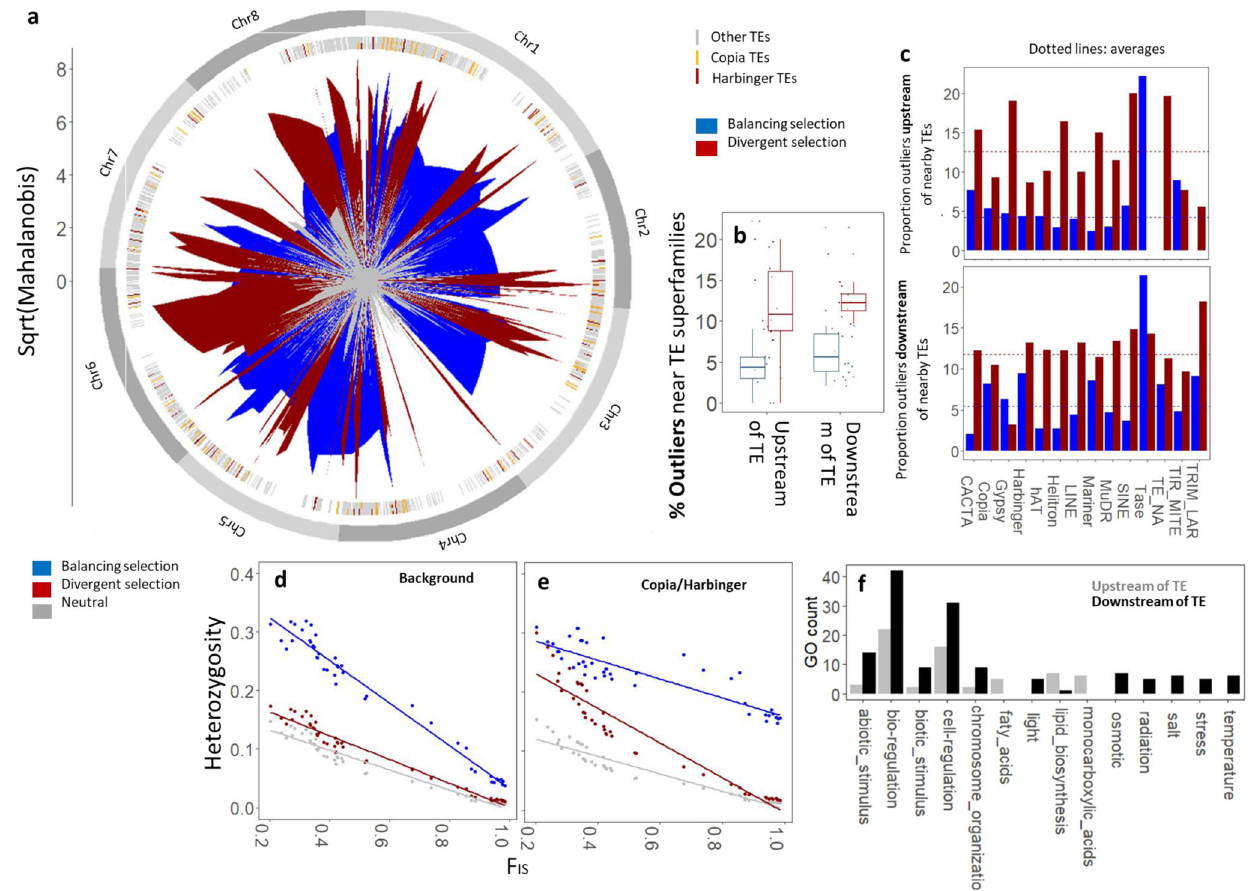
Fig. 4 | Genome-wide signatures of selection across TE superfamilies. The Mahalanobis distance represents the deviation from neutrality ( a ), with 4.86% and 12.17% of genome-wide SNPs manifesting signatures of balancing and divergent selection, respectively (Supplementary Data 1). Genome-wide signatures of diver- gent and balancing selection are similar upstream and downstream of TEs ( b ), but vary considerably among TE superfamilies ( c ). As compared to background het- erozygosity( H 0 ),CopiaandHarbingerelementsareassociatedwithelevatedlevels of nearby heterozygosity under inbreeding ( H TE ) for SNPs under balancing selec- tion ( d , e ). While signatures of selection are similar upstream and downstream of TEs, SNPs downstream of TEs are consistently implicated in biological processes